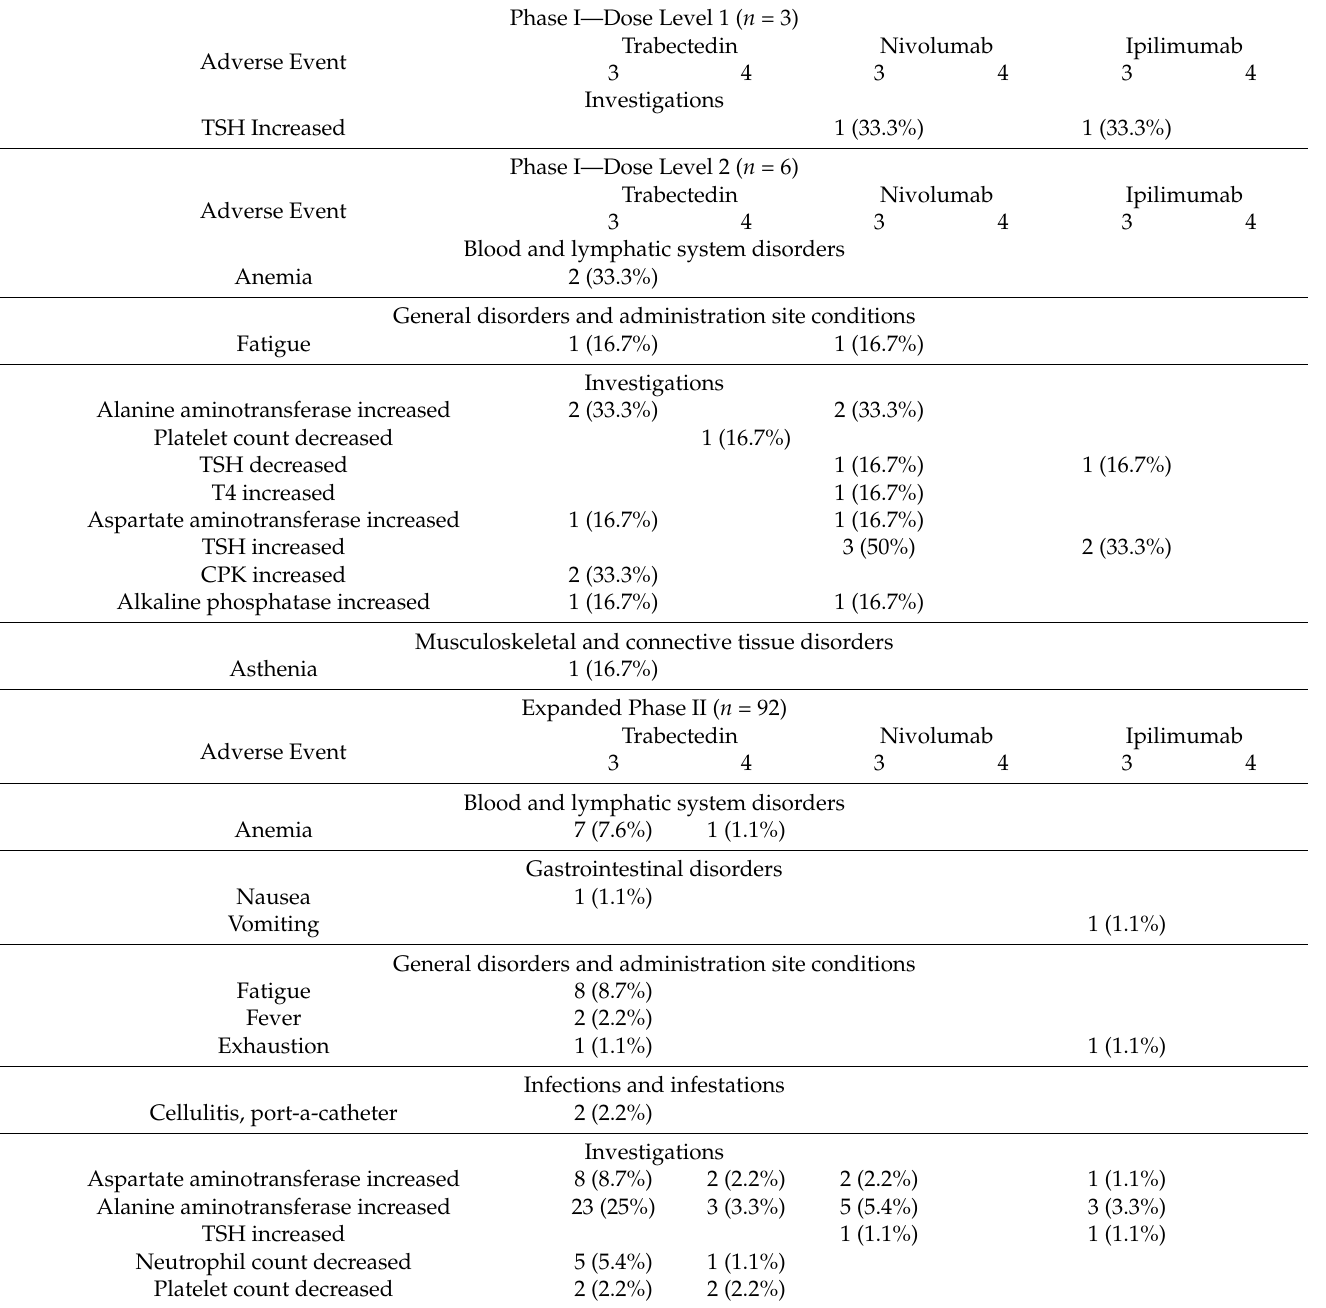
Table 2. ≥ Grade 3 Adverse Events Related to Study